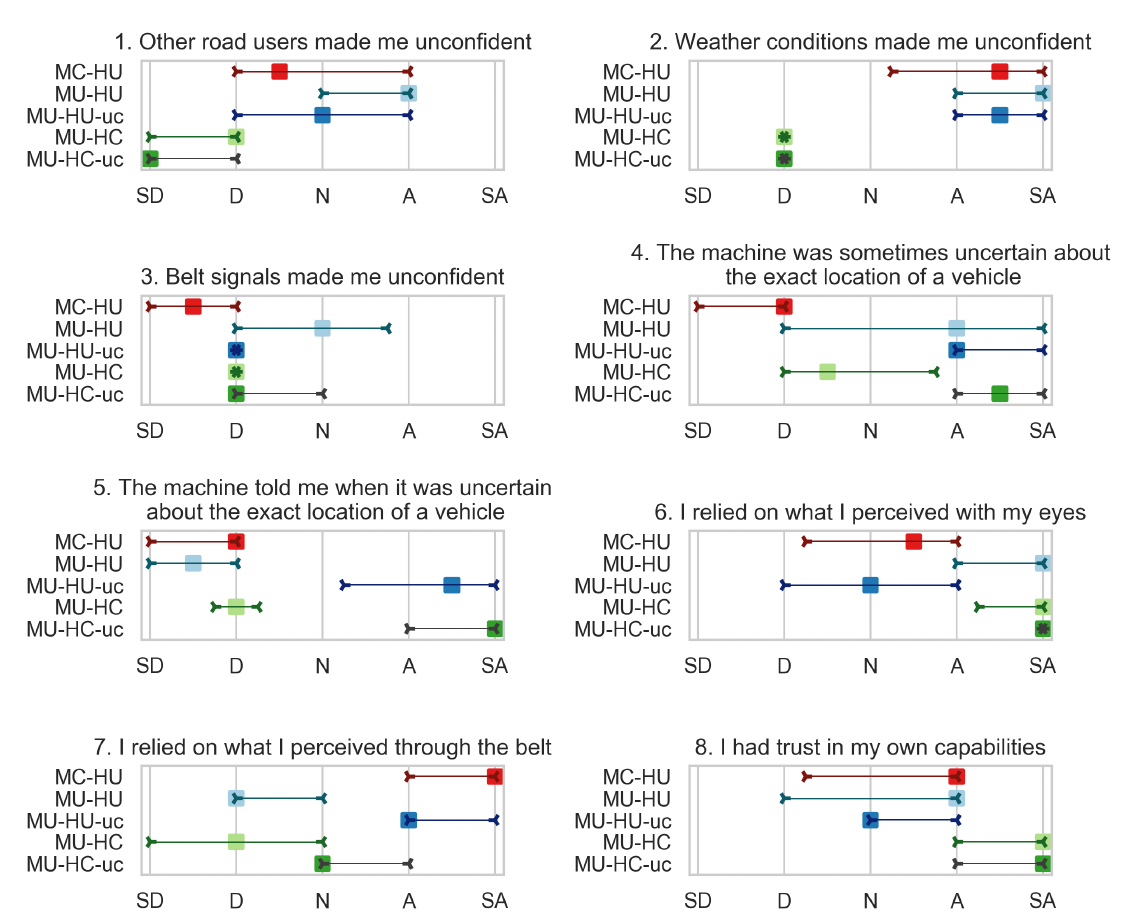
Figure 9. Median agreement ratings (square) and 25th and 75th percentiles on a custom 5-point Likert scale questionnaire. SD = Strongly Disagree, D = Disagree, N = Neutral, A = Agree, SA = Strongly